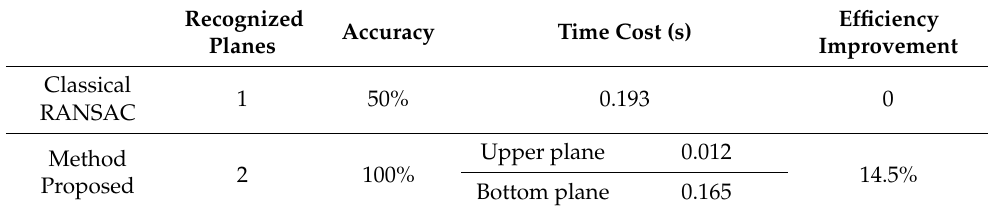
Table 2. Comparison of plane recognition